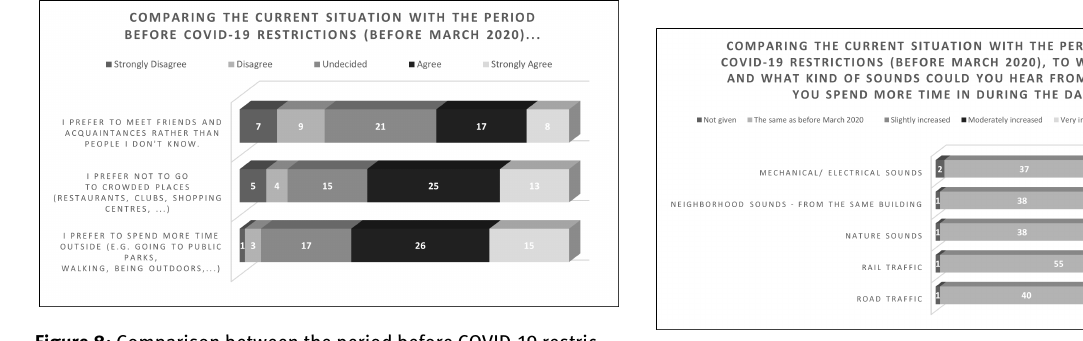
Figure 10: Type and intensity of sounds heard from home, compar- ing the current situation with the period before COVID-19 restric-